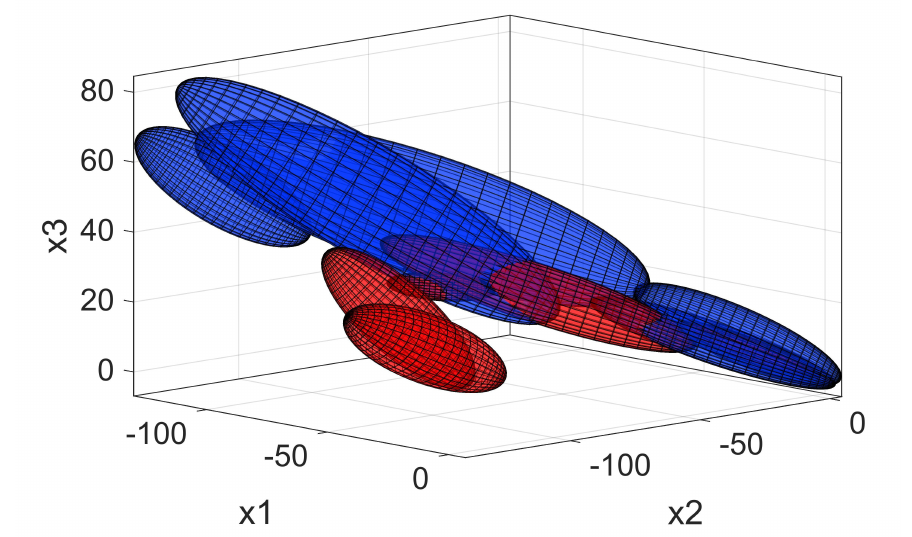
Figure 3. GMM representation in a reduced feature space for the lifting (blue) and sitting task (red); K lift = 5, K sit = 5. The axis x 1 , x 2 and x 3 represent right hip angle, left hip angle and trunk inclination, respectively. For reference, all movements start in the bottom right corner, continue towards the left side of the graph and come back to the starting